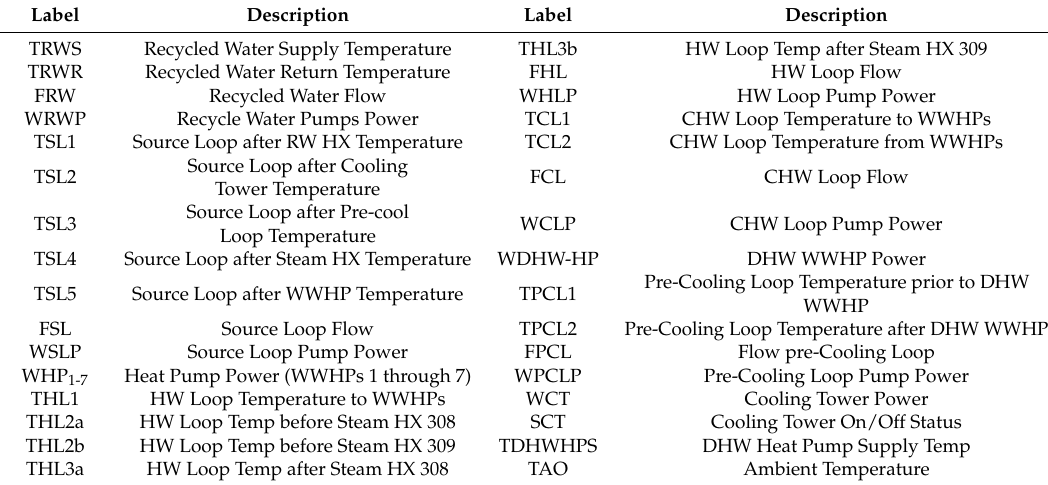
Table 1. Measured data points of the recycled water heat pump